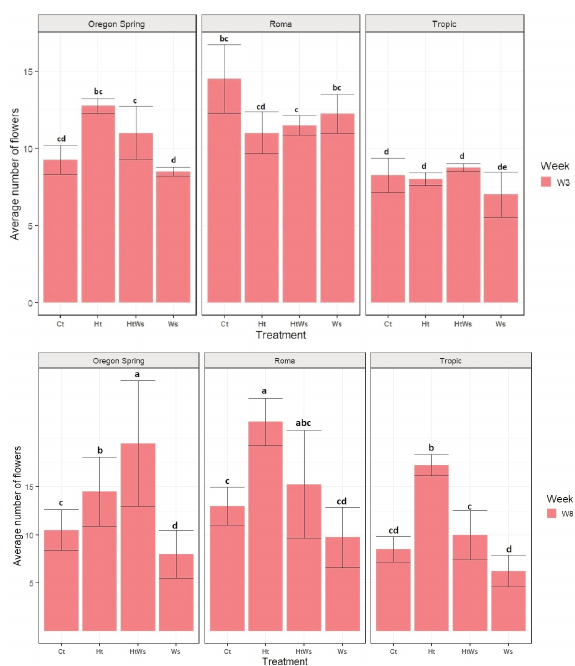
Fig. 5 ­ Average number of flowers per plant for the three toma­ to varieties (Oregon Spring, Roma and Tropic). The treat­ ments consist of Control (Ct), Water stress (Ws), Heat + Water stress (HtWs) and Heat (Ht). W3 and W8 = weeks of treatments imposition with measurements. Bars with the same letter are not significantly different at P<0.05 according to Turkey's test.